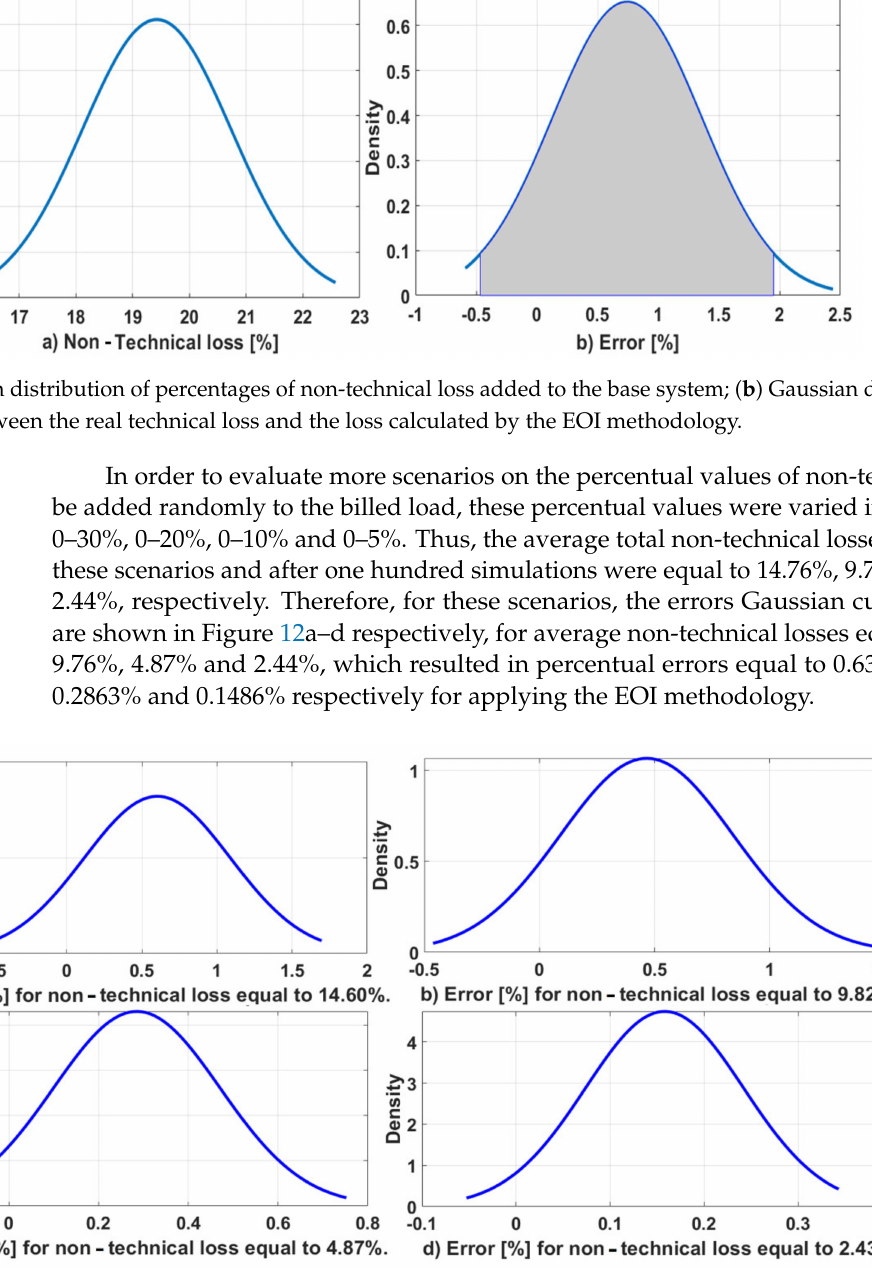
Figure 12. ( a ) Average percentual error equal to 0.6366%; ( b ) Average percentual error equal to 0.5004%; ( c ) Average percentual error equal to 0.2863%; ( d ) Average percentual error equal to